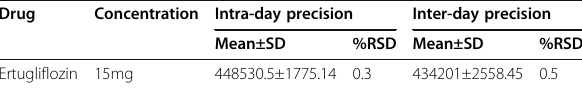
Table 6 Accuracy of the developed method for ertugliflozin ( n =3) Drug Level of addition